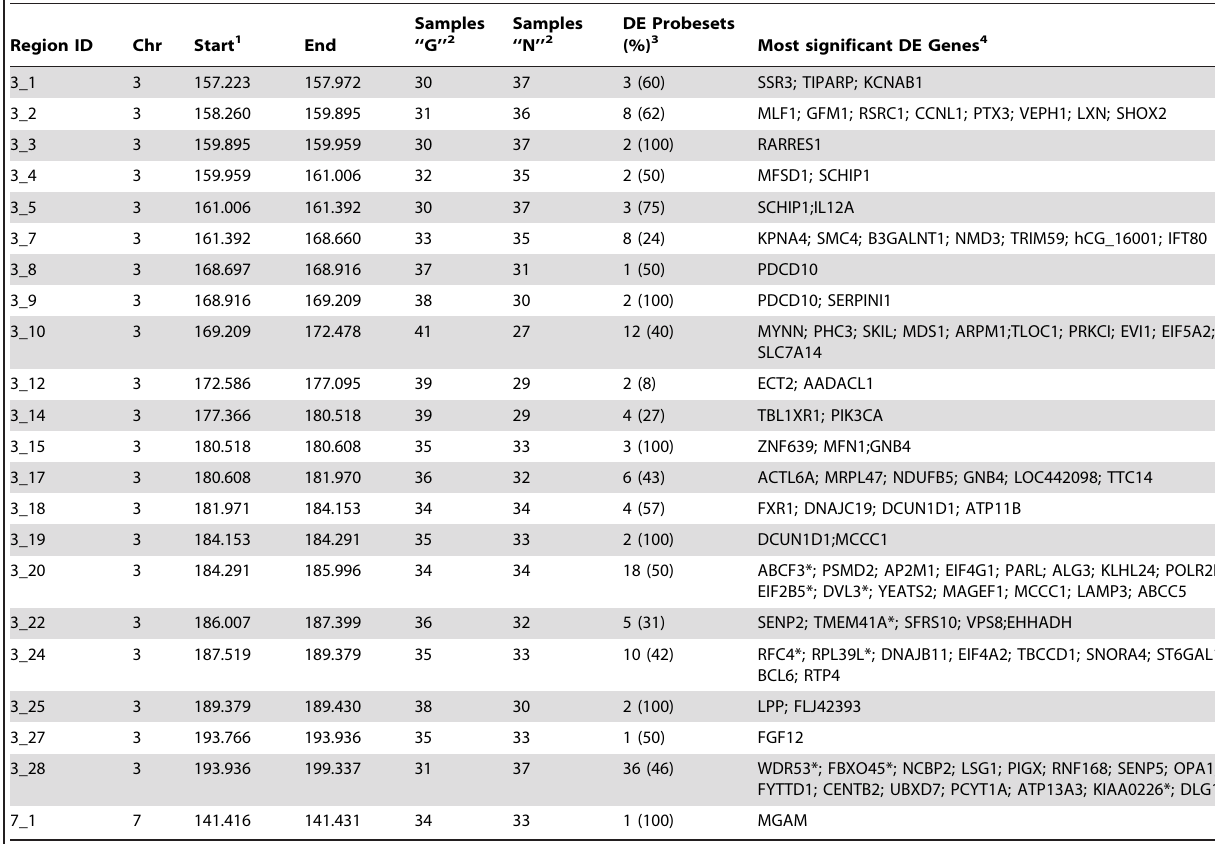
Table 2. Genes with increased expression on chromosomes 3 and